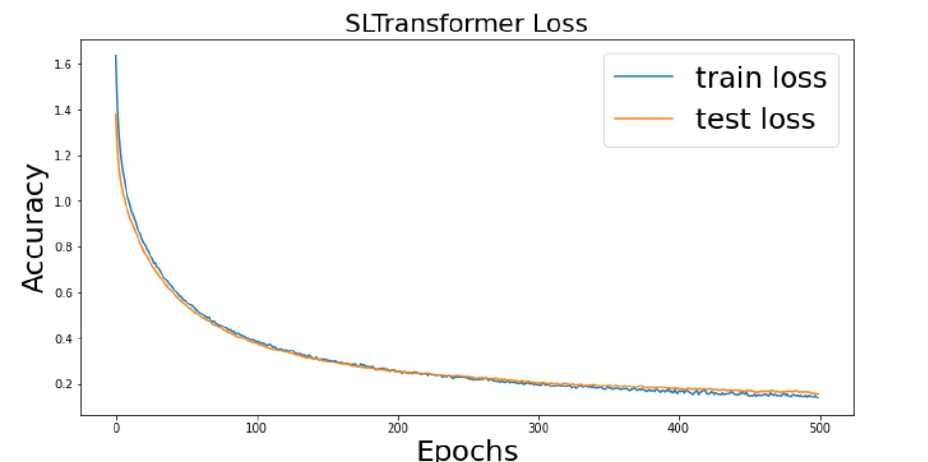
Figure 14. The loss graph of Sl transformer. The x -axis describes epochs and the y -axis describes loss.